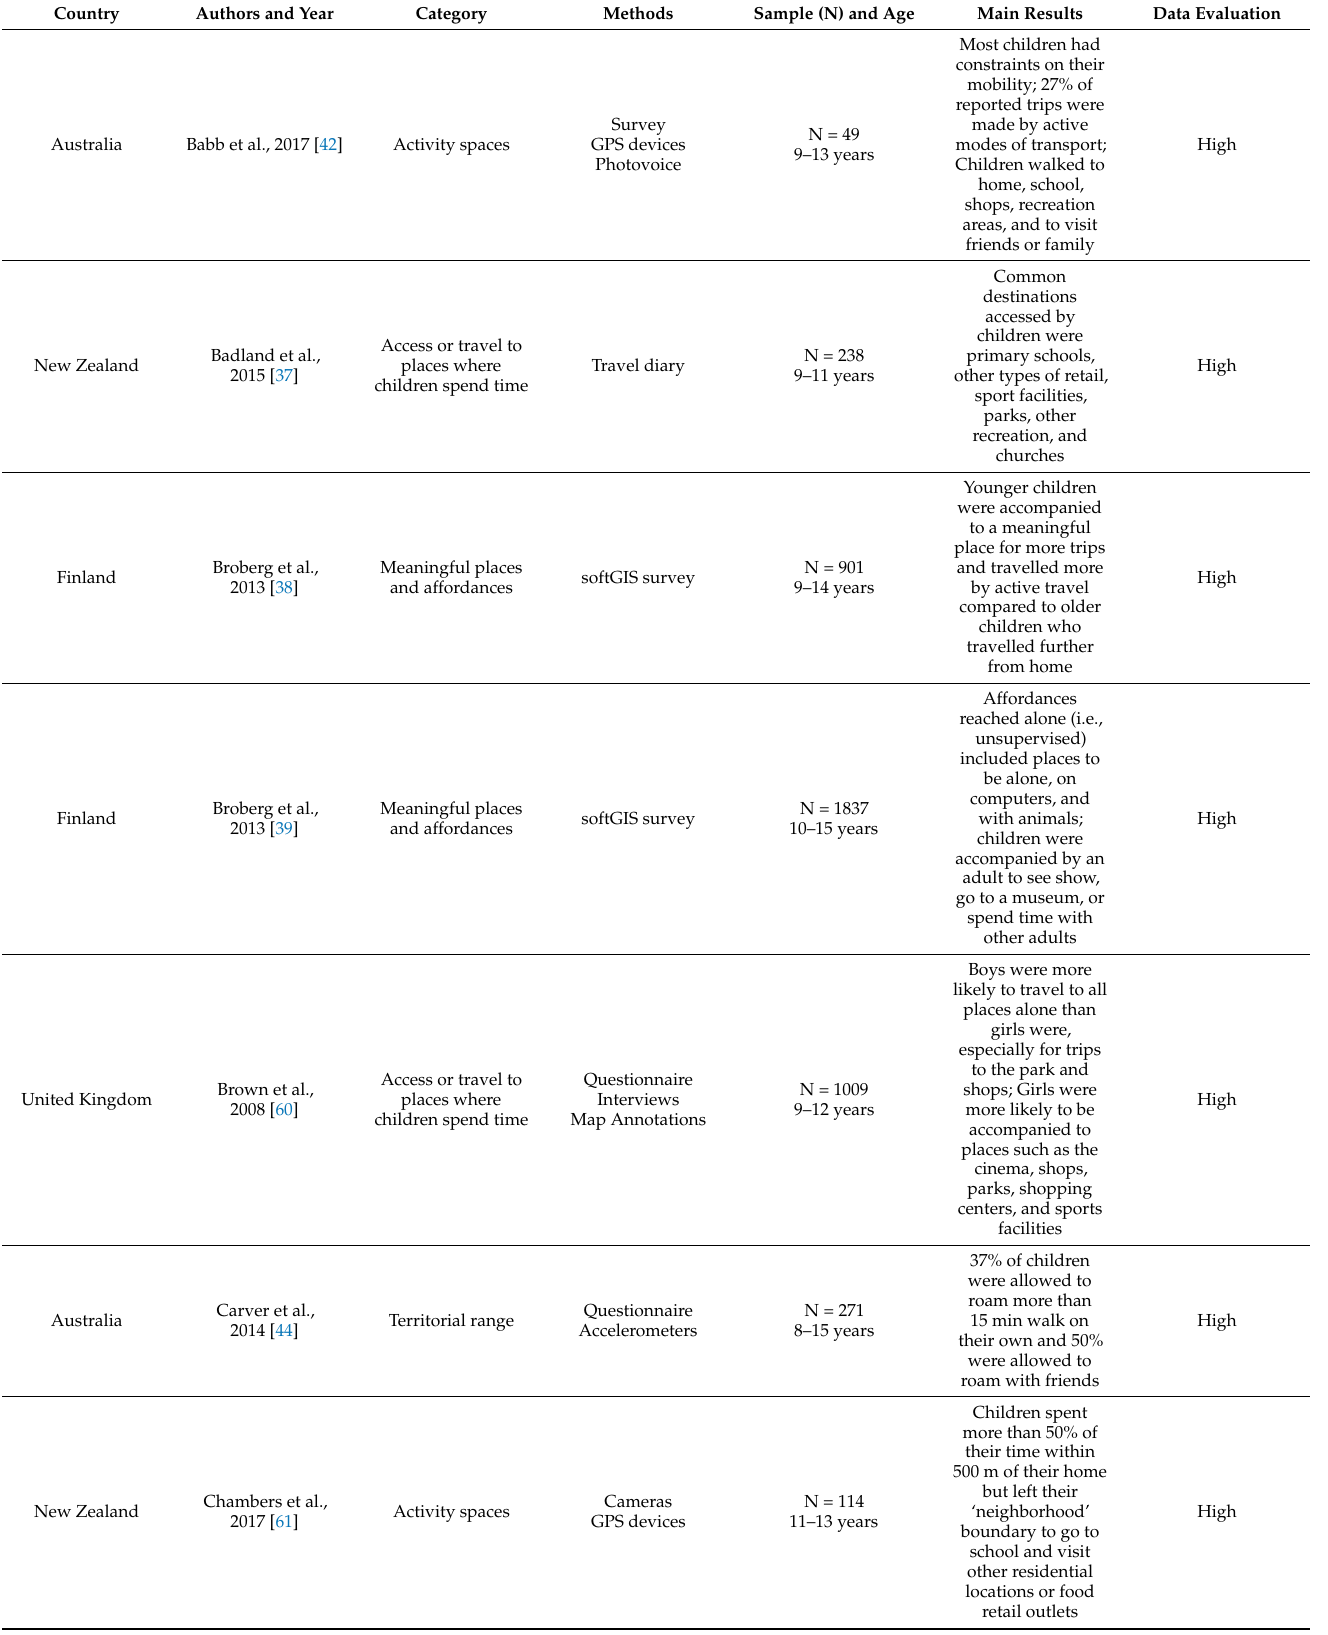
Table 2. Summary of peer-review articles included in the scoping